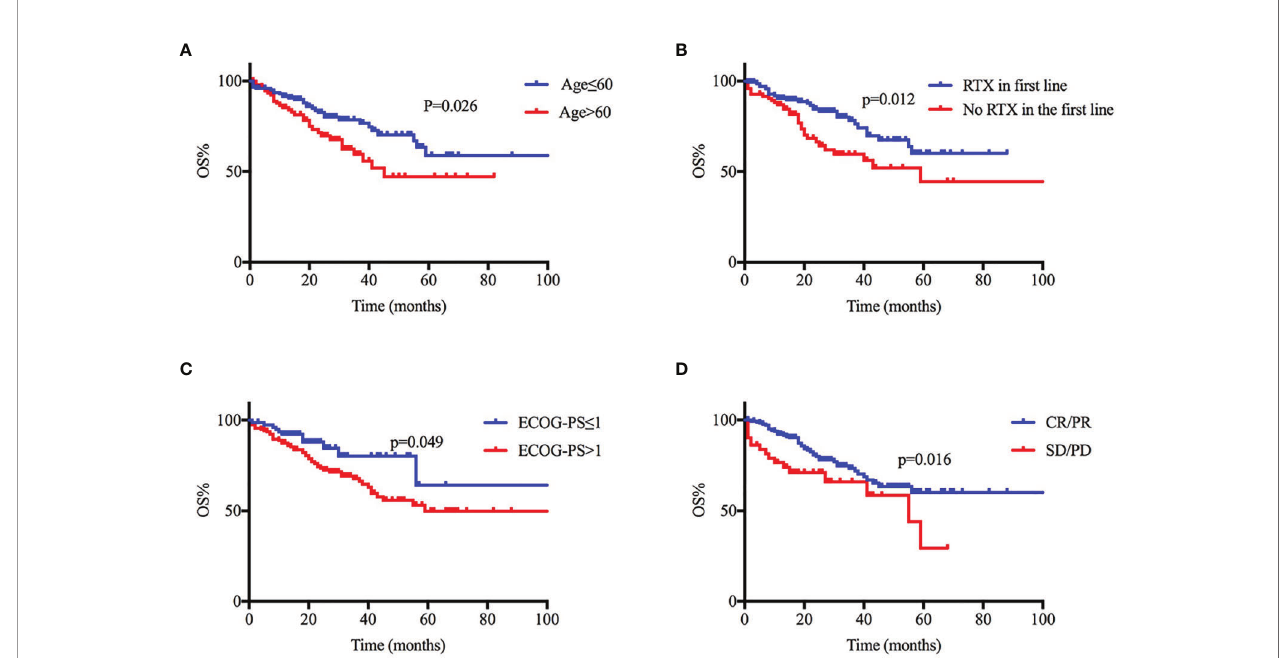
FIGURE 4 | Clinical prognostic variables and their relationship to progression-free survival (PFS) and overall survival (OS). (A-D) Age ≤ 60, ECOG-PS ≤ 1, early response to induction chemotherapy (IC), and use of RTX were associated with prolonged OS in univariate